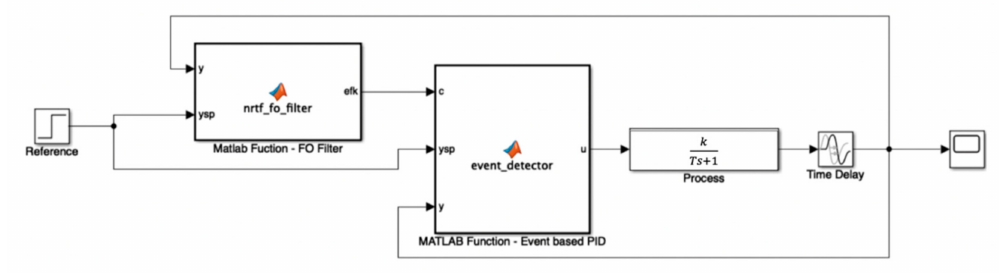
Figure 3. Simulink implementation of an event-based fractional order control